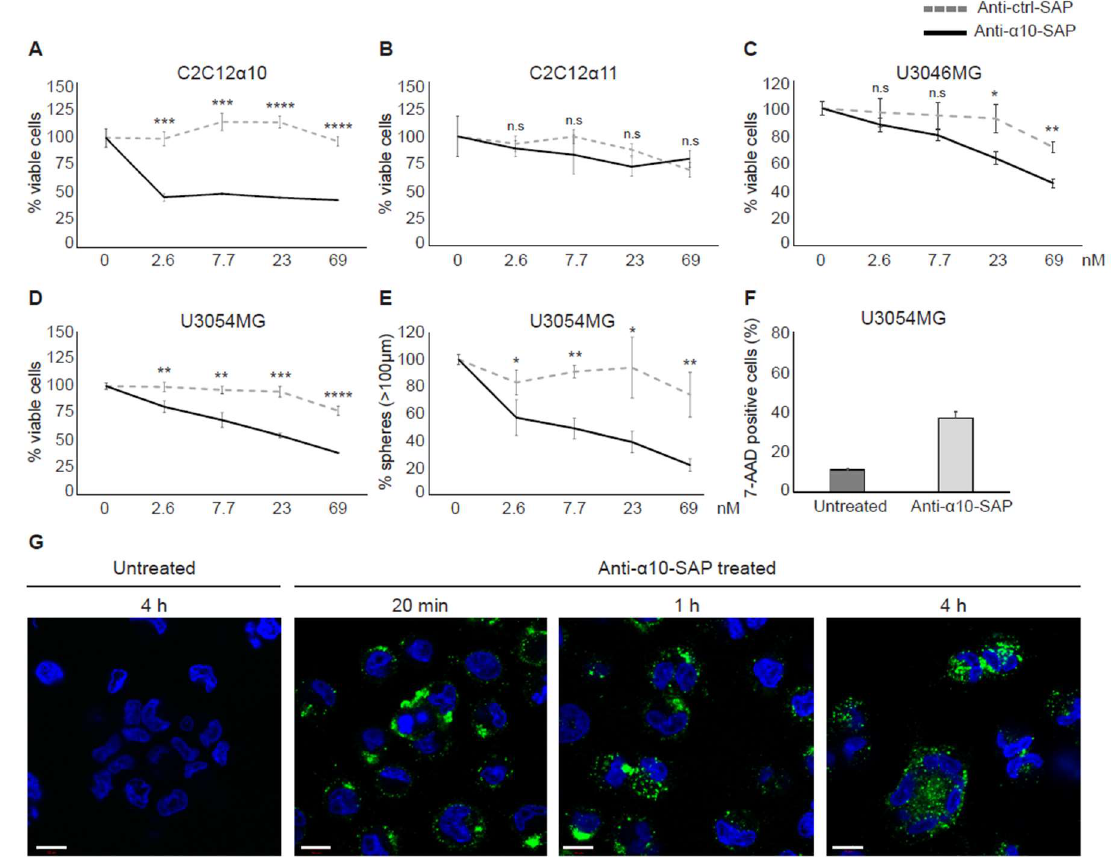
Figure 6. The antibody–drug conjugate (ADC), ribosome-inactivating cytotoxin saporin (anti- α 10-SAP), reduces the viability of integrin α 10-cells. ( A , B ) Viability analysis of mouse myoblast cells C2C12, transduced with integrin α 10 vector (C2C12 α 10) or integrin α 11 vector (C2C12 α 11) after treatment with anti- α 10-SAP or an isotype control IgG antibody conjugated to saporin (anti-ctrl-SAP) for 96 h. ( C , D ) Viability analysis of U3046MG and U3054MG GBM cells after treatment with increasing concentration of anti- α 10-SAP or anti-ctrl-SAP for 96 h. The relative amounts of viable cells were evaluated using the WST-1 assay and presented as a percentage of viable cells compared with the untreated controls. Viability data are one representative experiment per cell line, and error bars show the SD within triplicates. ( E ) Number of spheres formed by U3054MG cells after treatment with anti- α 10-SAP or anti-ctrl-SAP for 7 days. Spheres bigger than 100 µ m were counted. Data are one representative experiment, and error bars show the SD within triplicates. Unpaired two-tailed Student’s t -test were performed, where * p < 0.05; ** p < 0.01; *** p < 0.001, **** p < 0.0001. n.s.: not significant. ( F ) Flow cytometry analysis of U3054MG cells, cultured in the presence or absence of 20-22.5 nM anti- α 10-SAP for 7 days, stained with 7-AAD. Data are presented as a mean of two independent experiments, and error bars show the SD. ( G ) Binding and internalization of anti- α 10-SAP visualized at 20 min, 1h, and 4 h by immunolabeling of the monoclonal integrin α 10 antibody with secondary IgG antibodies against mouse IgG (conjugated with Alexa Fluor 488). Nuclei were stained blue with DAPI. Scale bars represent 10 µ